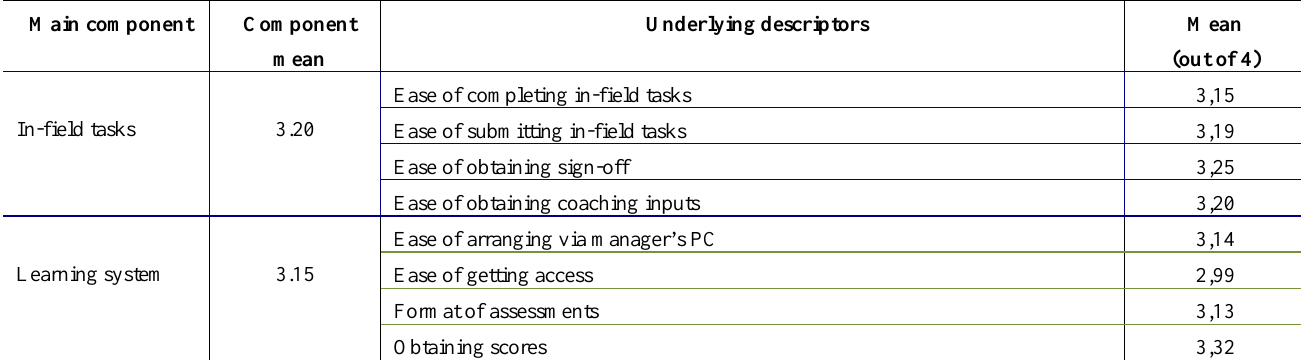
Table 4: Rating of in-field tasks and learning system assessment Main